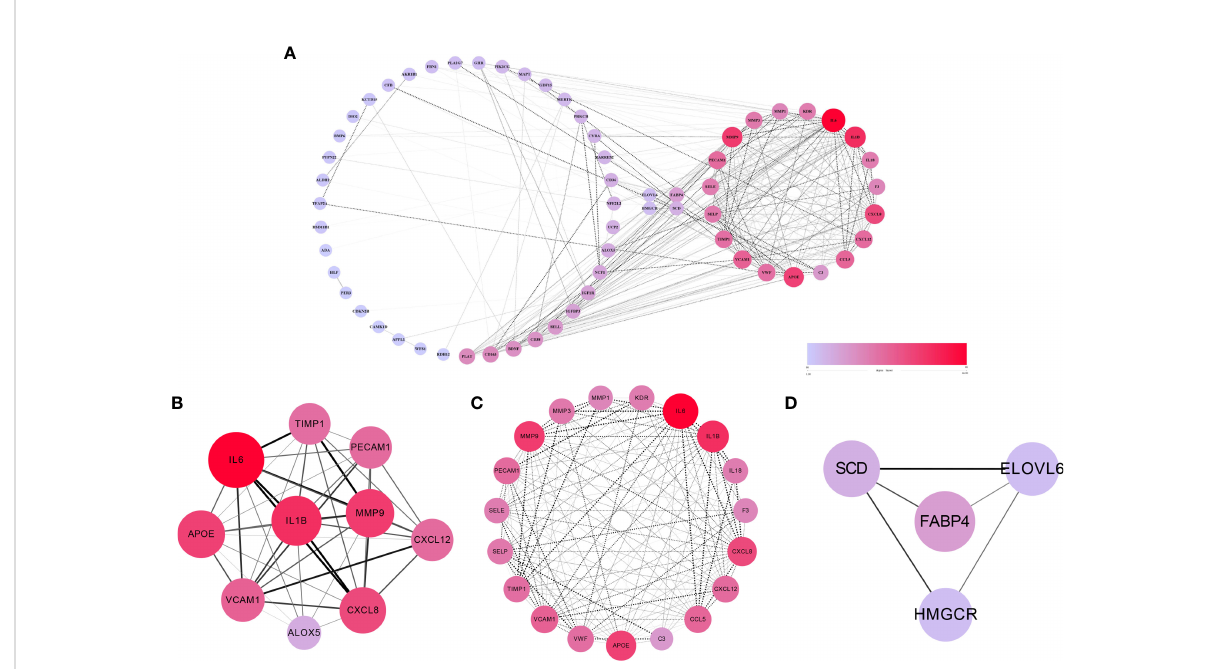
FIGURE 3 The results of PPI network, hub genes and signi fi cant modules. (A) PPI network of cross-talk genes. (B) Top 10 hub genes. (C) Signi fi cant module 1 (contained 19 nodes and 151 edges). (D) Signi fi cant module 2 (contained 4 nodes and 5